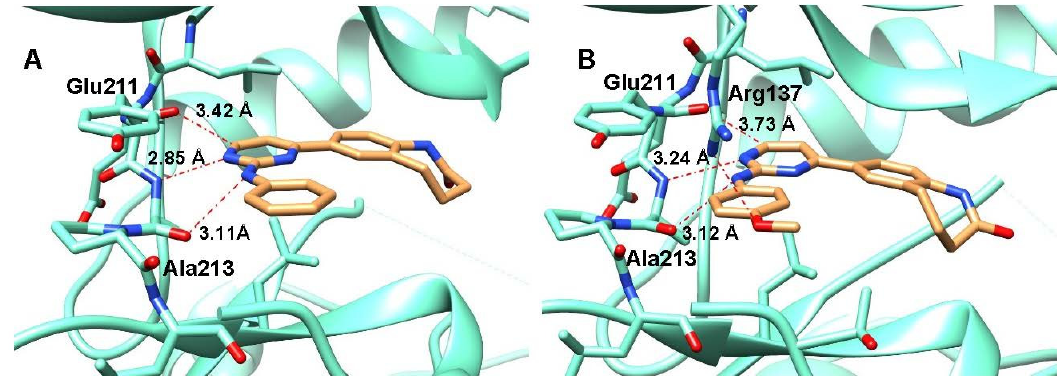
Figure 4. Cocrystal structures of Aurora A in complex with 2a ( A ) and 2c ( B ). ( A ): The characteristic donor–acceptor–donor triad of hydrogen bonds from the inhibitors to the amino acids Glu211 and Ala213 of the hinge area is observed. ( B ): In the complex with 2c , an additional weak hydrogen bond between the methoxy group and Arg137 (D–A = 3.26 Å) is formed. Hydrogen bonds are shown in red chain lines. Table 1. Data collection and refinement statistics of the Aurora A complex with ligands 2a and 2c .